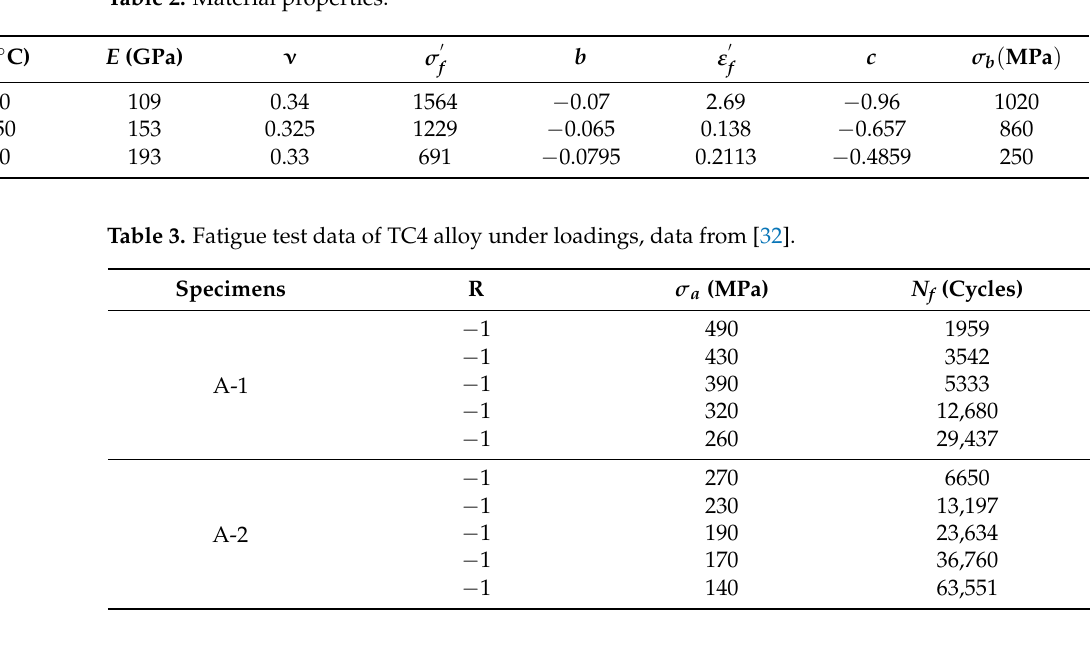
Table 2. Material properties.